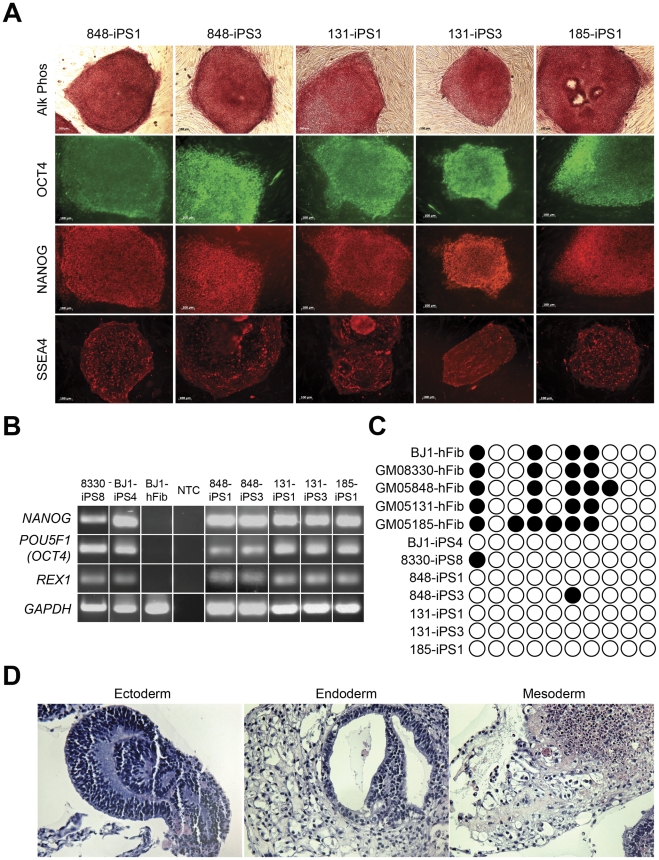
Derivation and Characterization of FXS Induced Pluripotent Stem Cells.(A) Alkaline phosphatase enzymatic and pluripotent marker (OCT4, NANOG and SSEA-4) immunocytochemical analysis of FXS patient-derived iPSC clones. (B) Endogenous OCT4, NANOG and REX1 pluripotency-associated transcript expression as analyzed by RT-PCR in indicated iPSC lines and fibroblasts (NTC - non-template containing control). (C) Bisulphite pyrosequencing analysis of the endogenous OCT4/POU5F1 promoter in indicated lines (open circles, unmethylated (<50%) CpGs; black circles, methylated CpGs). (D) Embryoid body pathological evaluation of H&E stained sections (clone 848-iPS1 shown) indicating representative ectoderm (neural epithelium, left), endoderm (respiratory epithelium, center) and mesoderm (connective tissue, right) germ layers.